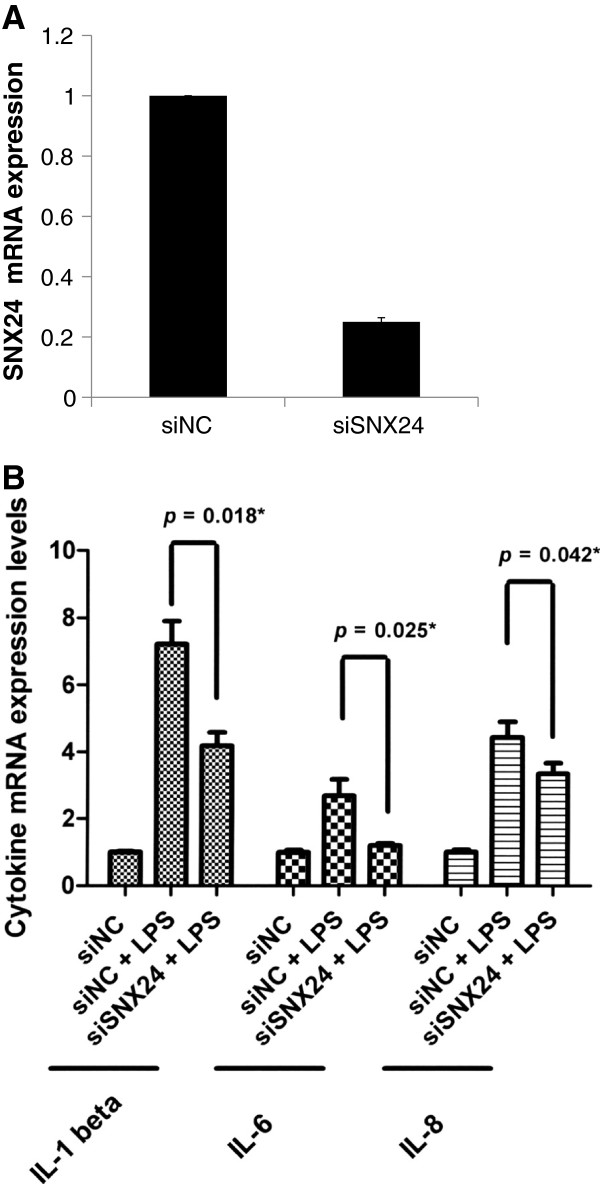
Effect of SNX24 knockdown on proinflammatory cytokines. HUVECs were transfected with siSNX24 or siNC for 24 h at 37°C followed by 100 μg/mL LPS for another 24 h. A. siSNX24 knockdown efficacy in HUVECs by using RT-qPCR assay. B.IL-1 beta, IL-6, and IL-8 mRNA expression was quantified by RT-qPCR. * p < 0.05 versus siNC + LPS. Data represent mean ± SD for 3 independent experiments.